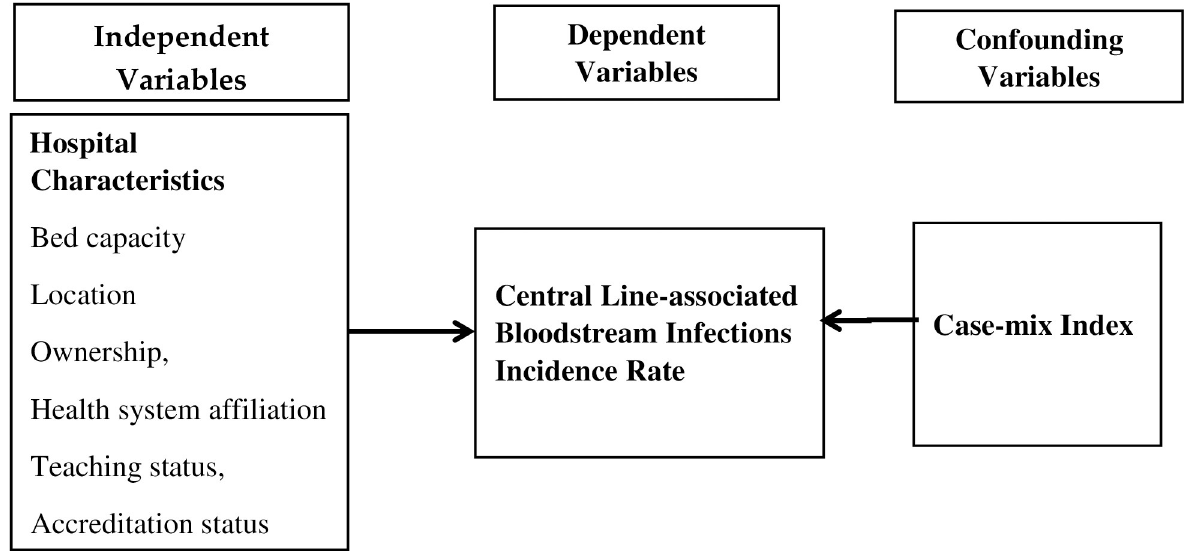
Fig 1. Conceptual